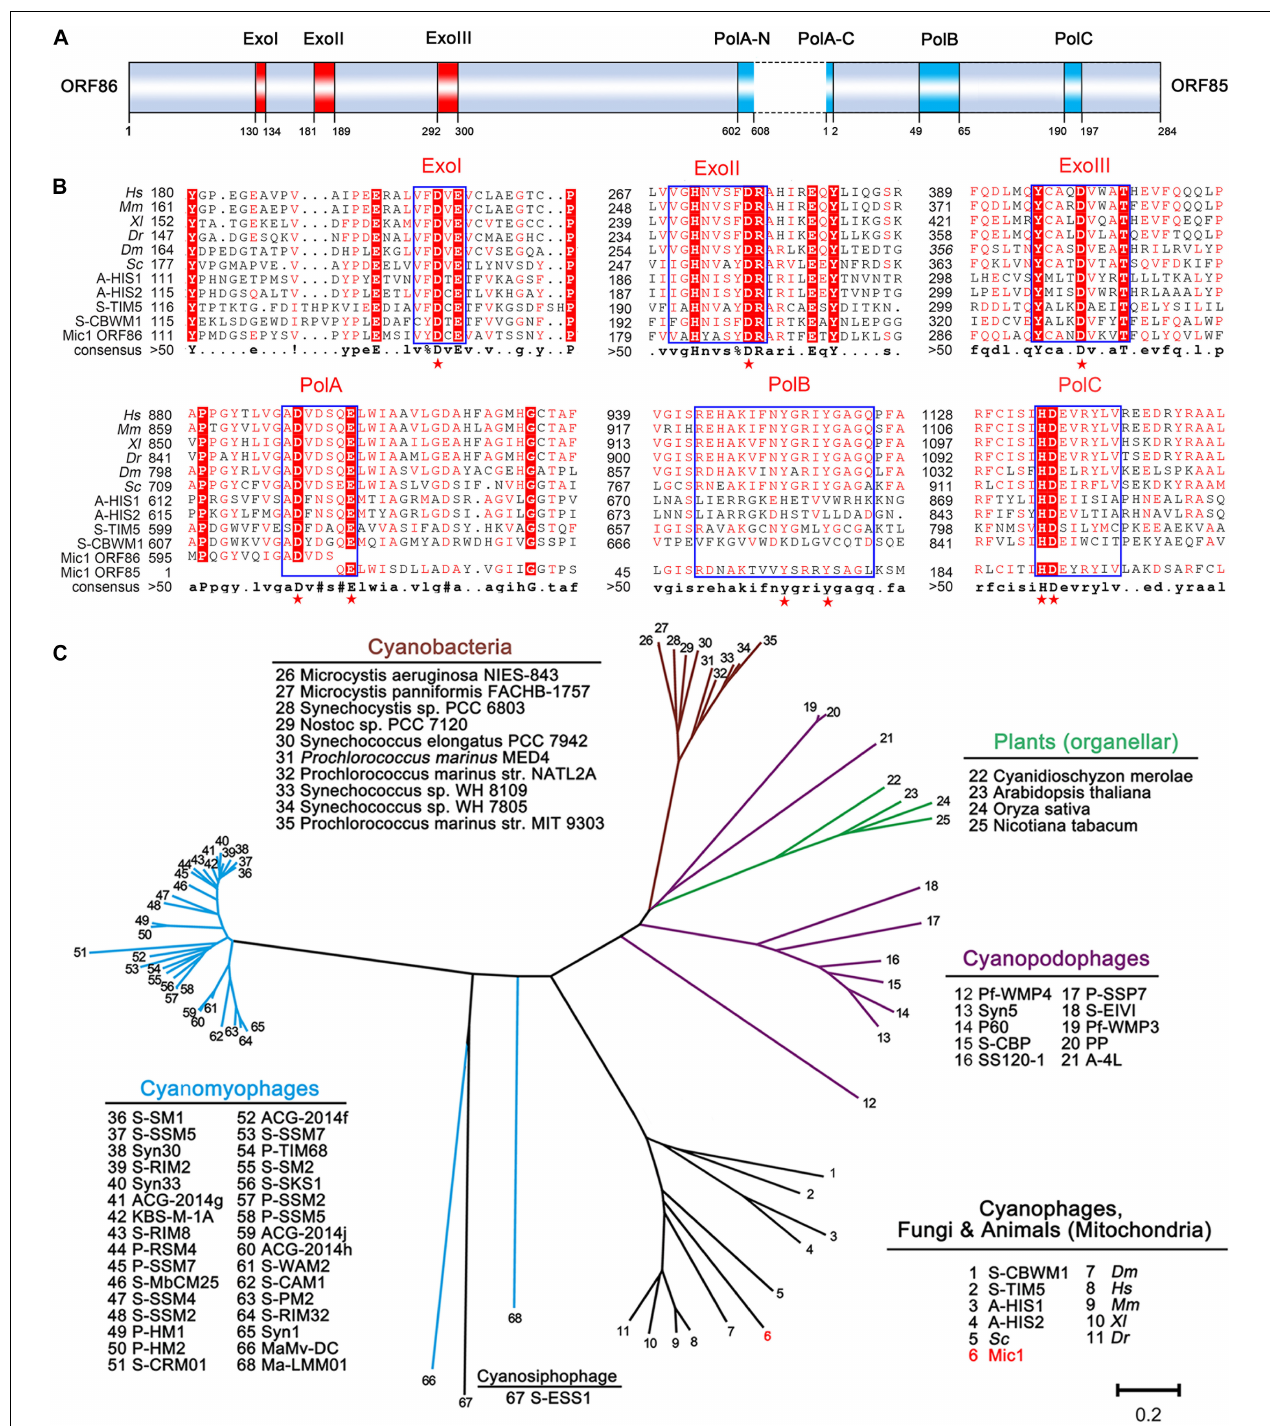
FIGURE 6 | Analyses of DNA polymerase γ . (A) Domain organization of Mic1 DNA polymerase γ . The red and blue boxes indicate the conserved exonuclease motifs I–III and polymerase motifs A–C of DNA polymerase γ , respectively. The dotted box indicates the intron between ORF85 and ORF86. (B) Multiple-sequence alignment of the conserved DNA polymerase γ from different species. Boxes frame the sequences that are highly conserved, and the key conserved amino acid residues in the exonuclease and polymerase domains are depicted by red stars. The abbreviations are Hs , Homo sapiens ; Mm , Mus musculus ; Xl , Xenopus laevis ; Dr , Danio rerio ; Dm , Drosophila melanogaster ; Sc , Saccharomyces cerevisiae ; A-HIS1 and A-HIS2, Acaryochloris marina siphovirus; S-TIM5, Synechococcus marina myovirus, S-CBWM1, Synechococcus marina myovirus. (C) Phylogenetic relationship of DNA polymerases among cyanophages, cyanobacteria and plant organelles. Unrooted phylogenetic tree was constructed based on the neighbor-joining method. The scale bar represents 0.2 changes per amino acid.